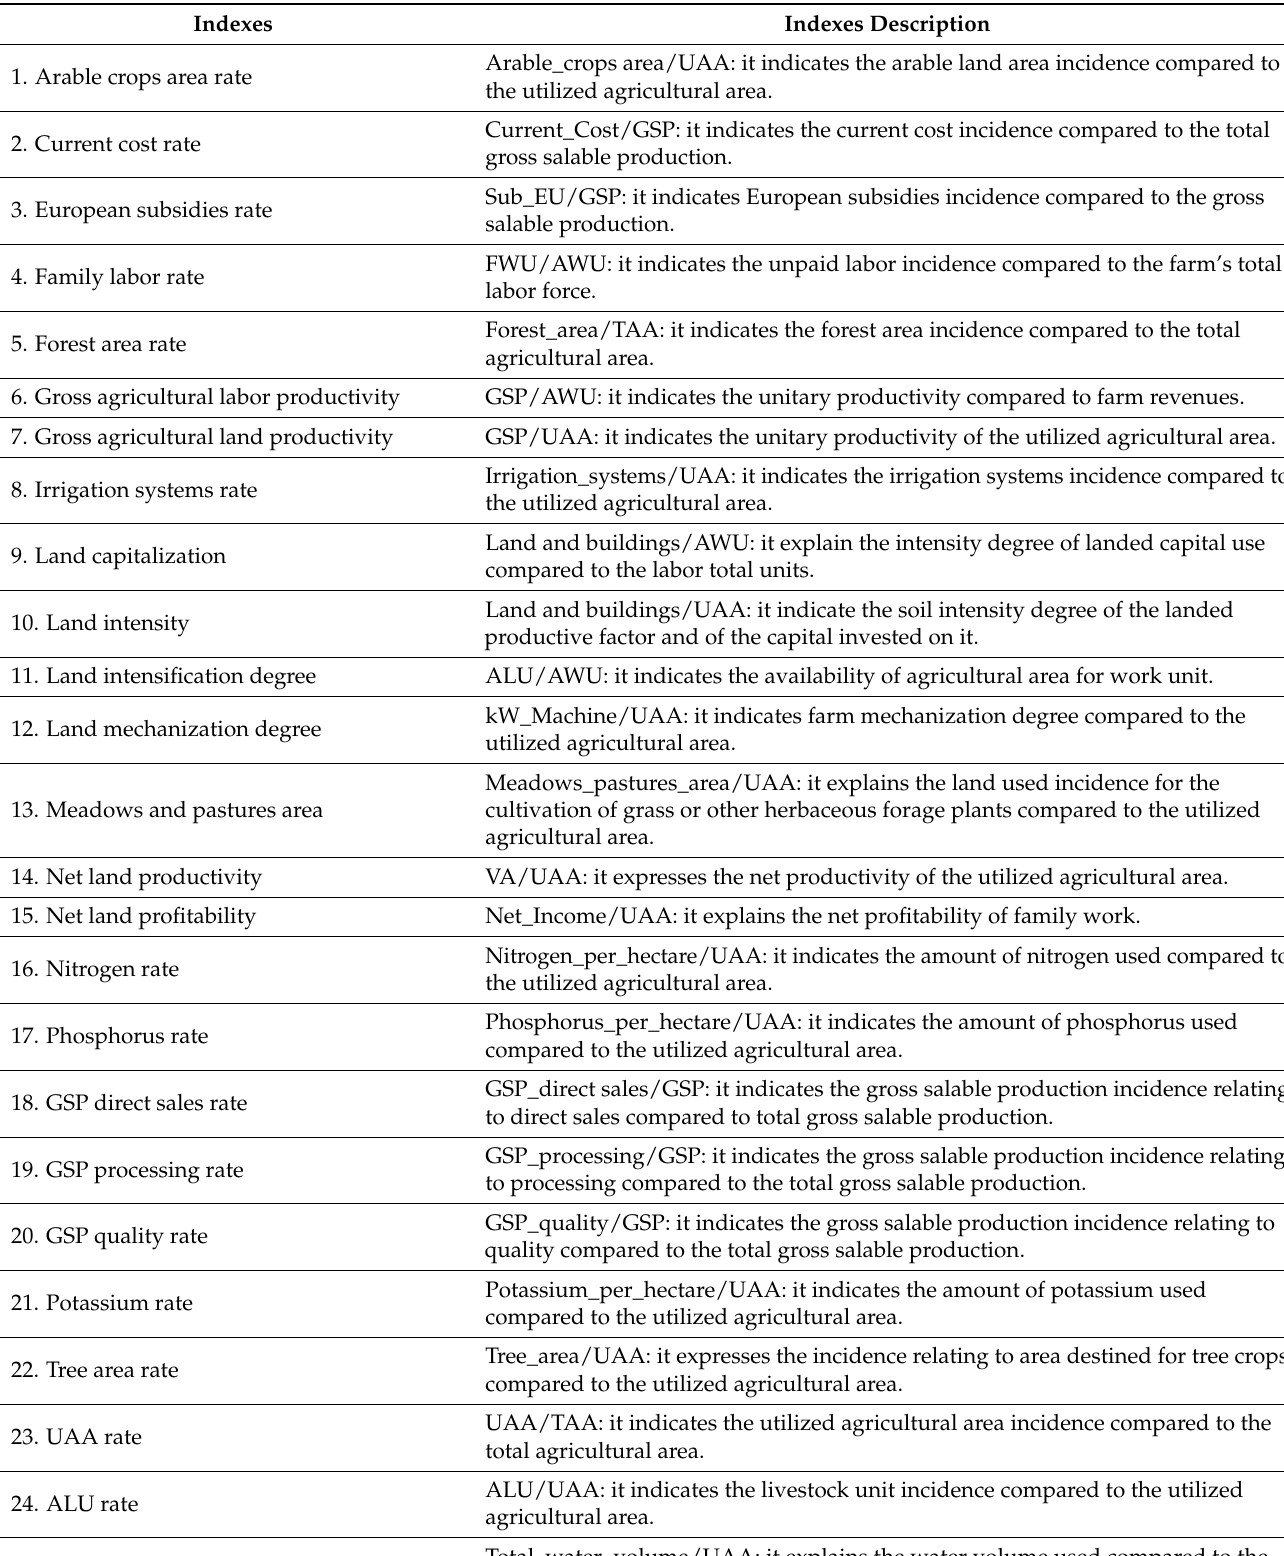
Table 2. Description of the indexes used in the Principal Components Analysis